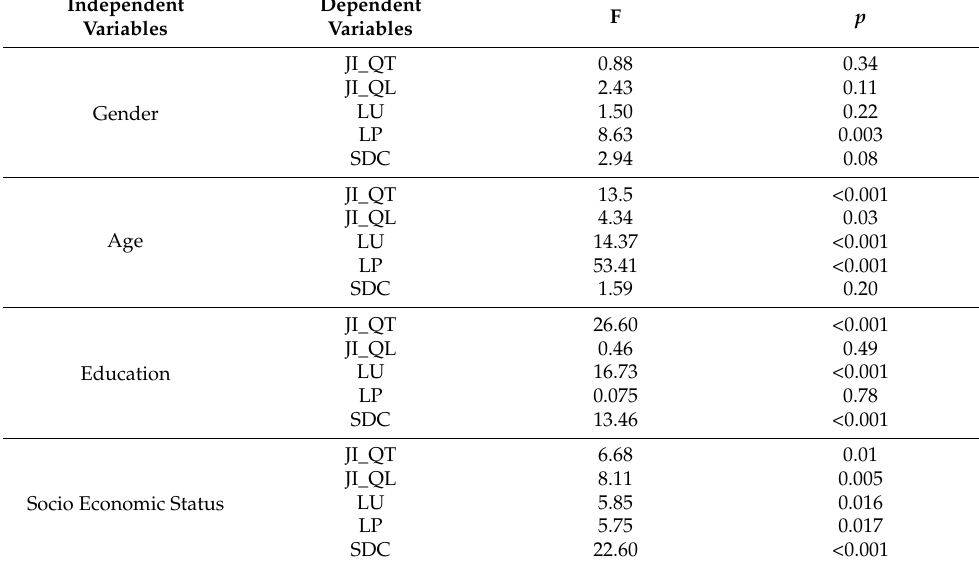
Table 5. MANOVA’s Univariate Tests.